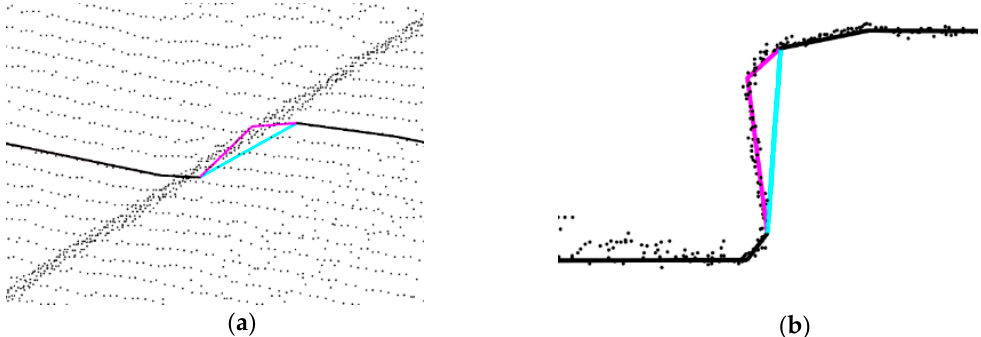
Figure 8. Profile view of the road curb vertical variation schema. Red line represents the infra-excavation curb situation.